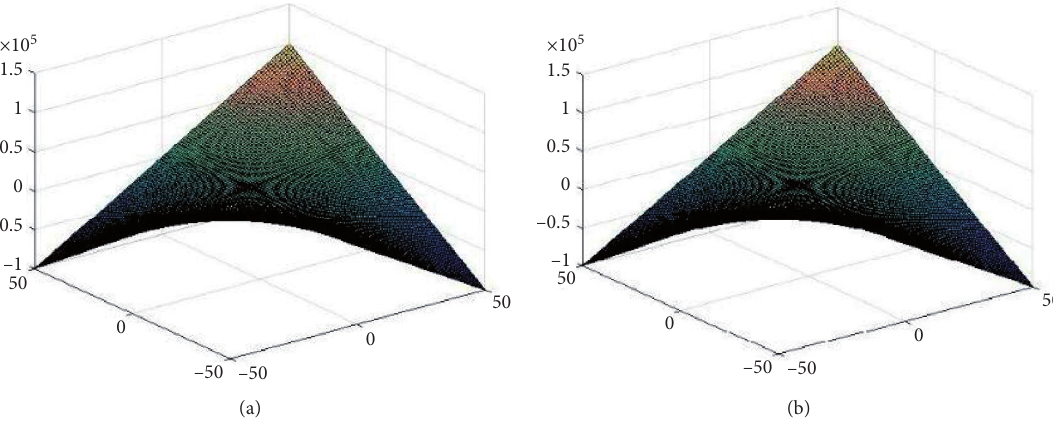
Figure 3: First Zagreb index plotted in 3D.